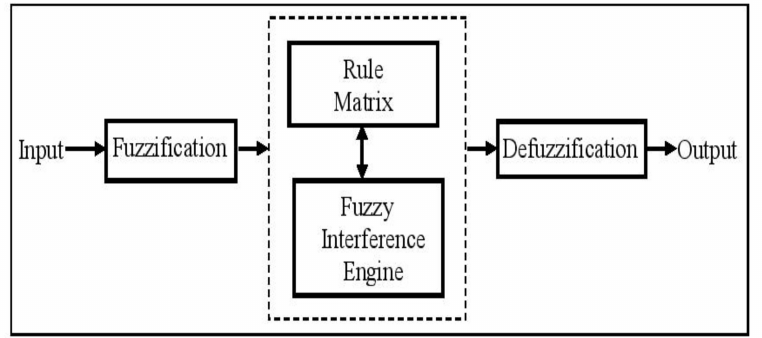
Figure 8. Operational diagram fuzzy logic